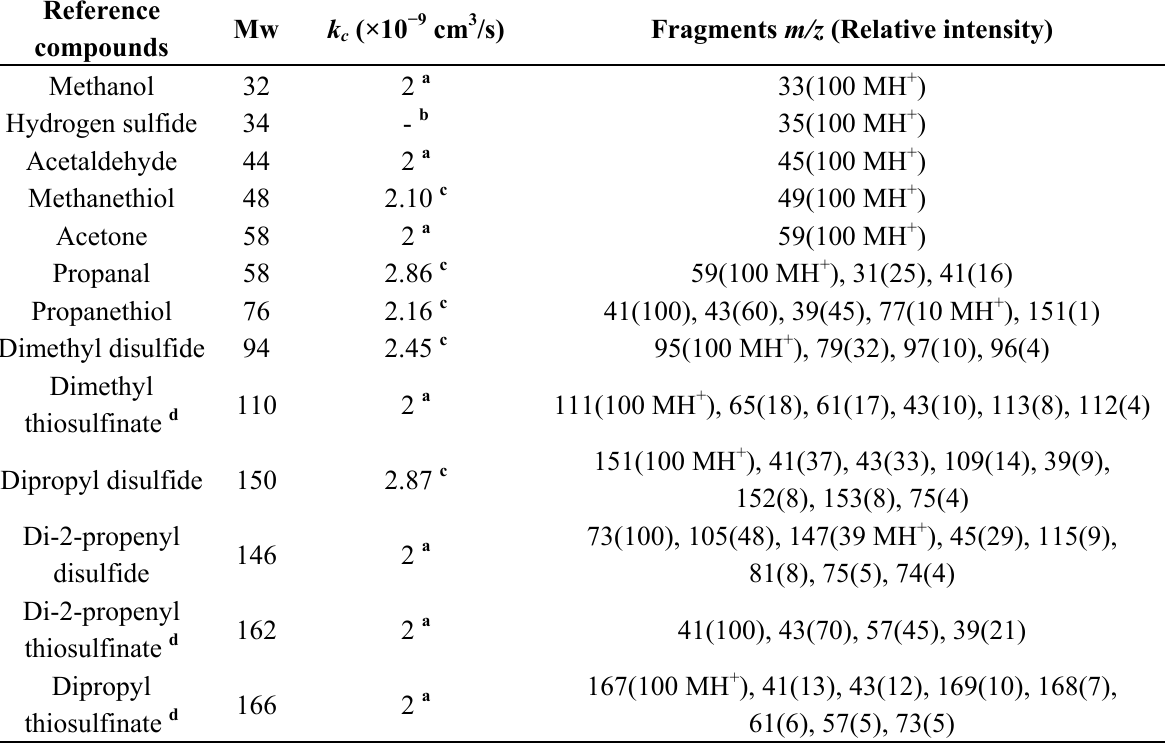
Table 1. Reference mass spectra of compounds used for identification of VOCs from freshly cut onions. Proton transfer reaction rate constants ( k relative amounts are